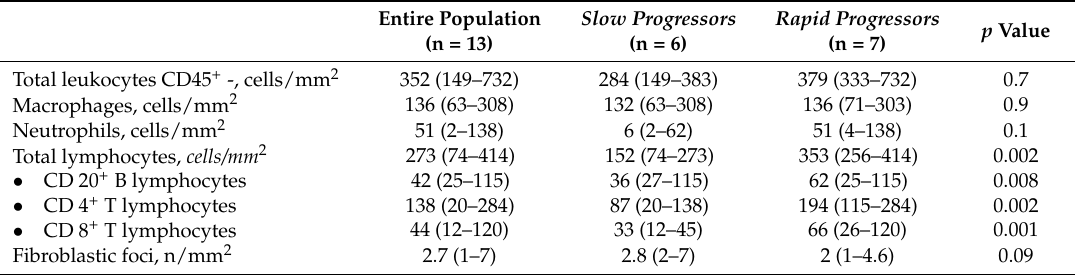
Table 2. Inflammatory cells numbers of the entire population with lung pathology (n = 13), including six slow and seven rapid